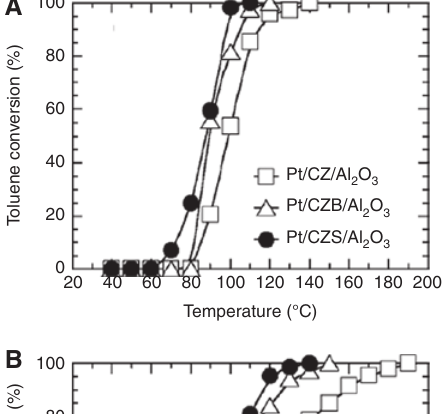
O , 2 3 O catalysts (CZ, Ce Zr O ; CZB, 2 3 0.79 0.21 2.0 Zr Sn O ). Reproduced from [92] 0.68 0.17 0.15 2.0